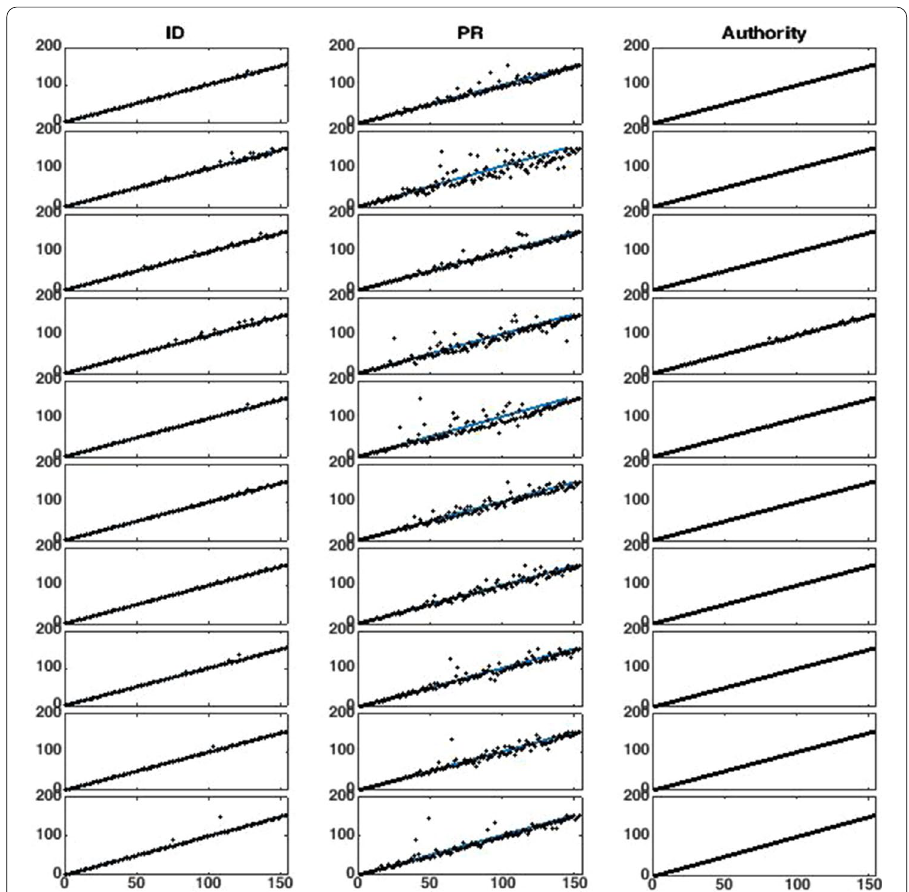
Fig. 2 Comparison of the rank of 154 countries in in 154-country and 234-country networks based on in-degree, PageRank, and authority in 10 commodity groups and import sector. Each row represents a specific commodity group. The vertical axis shows the 154 common countries in the 234-country network. The horizontal axis shows 154 countries in the 154-country network. The plot represents the fitted line to the rank of 154 common